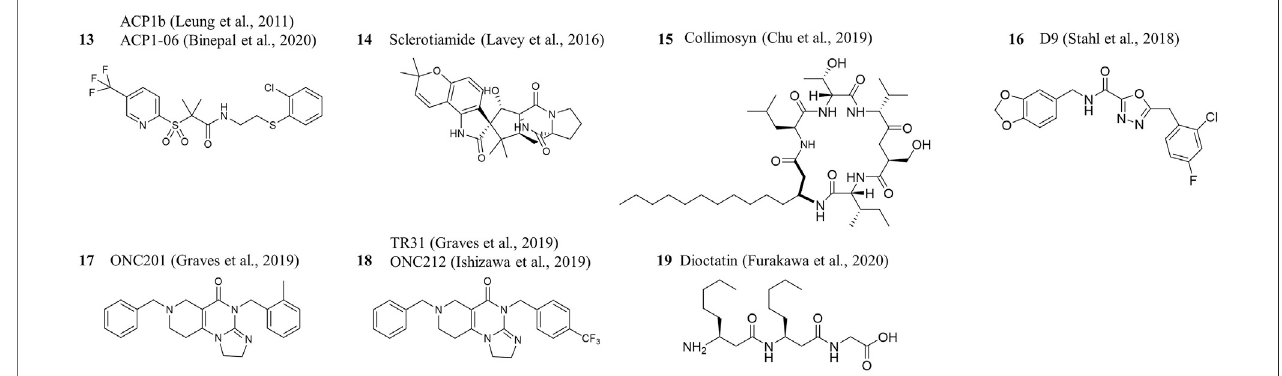
FIGURE 4 | ClpP activators from other structural